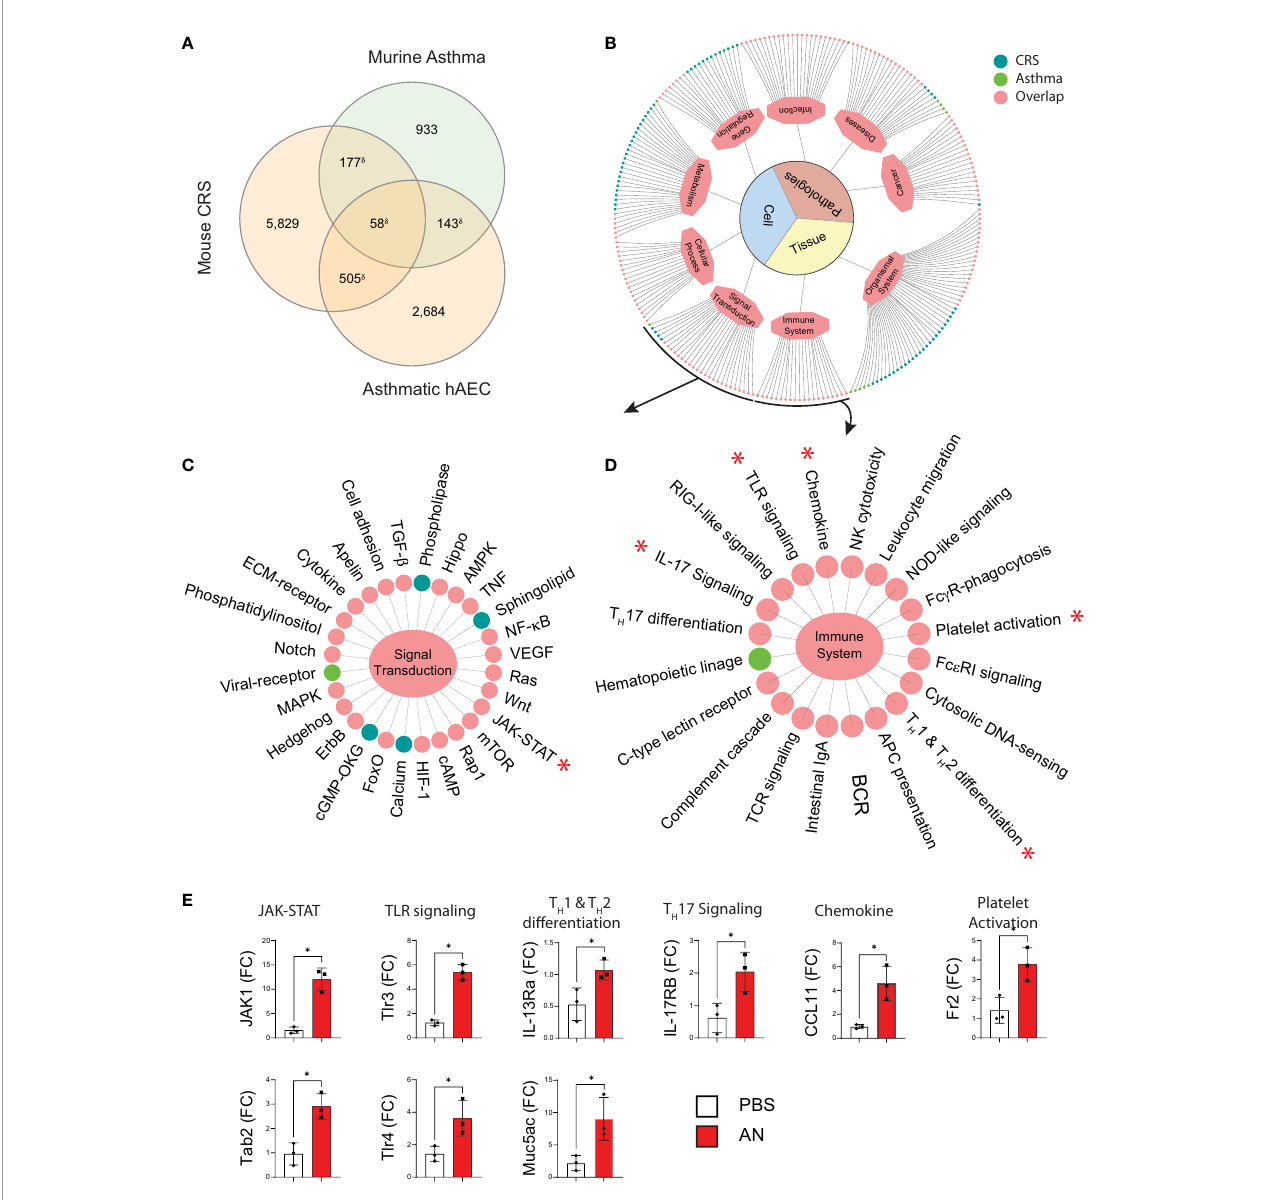
FIGURE 5 | Murine fungal rhinosinusitis has an asthmatic in fl ammatory gene signature. (A) Venn diagram showing overlap between DEGs and the asthma signature gene set for murine asthma21 and asthmatic human airway epithelial cells (hAEC). (B) KEGG pathway enrichment network and sub-networks including (C) Signal Transduction and (D) Immune System, for sinus DEGs (CRS; green), murine asthma (Asthma; blue), and co-enriched (Overlap; pink) pathways. (E) qPCR validation of select genes in co-enriched pathways (*) from sinus total RNA. d p < 5e-15 by hypergeometric analysis; p adj < 0.05 for KEGG pathway enrichment; * p < 0.05, n = 3 by Student ’ s t